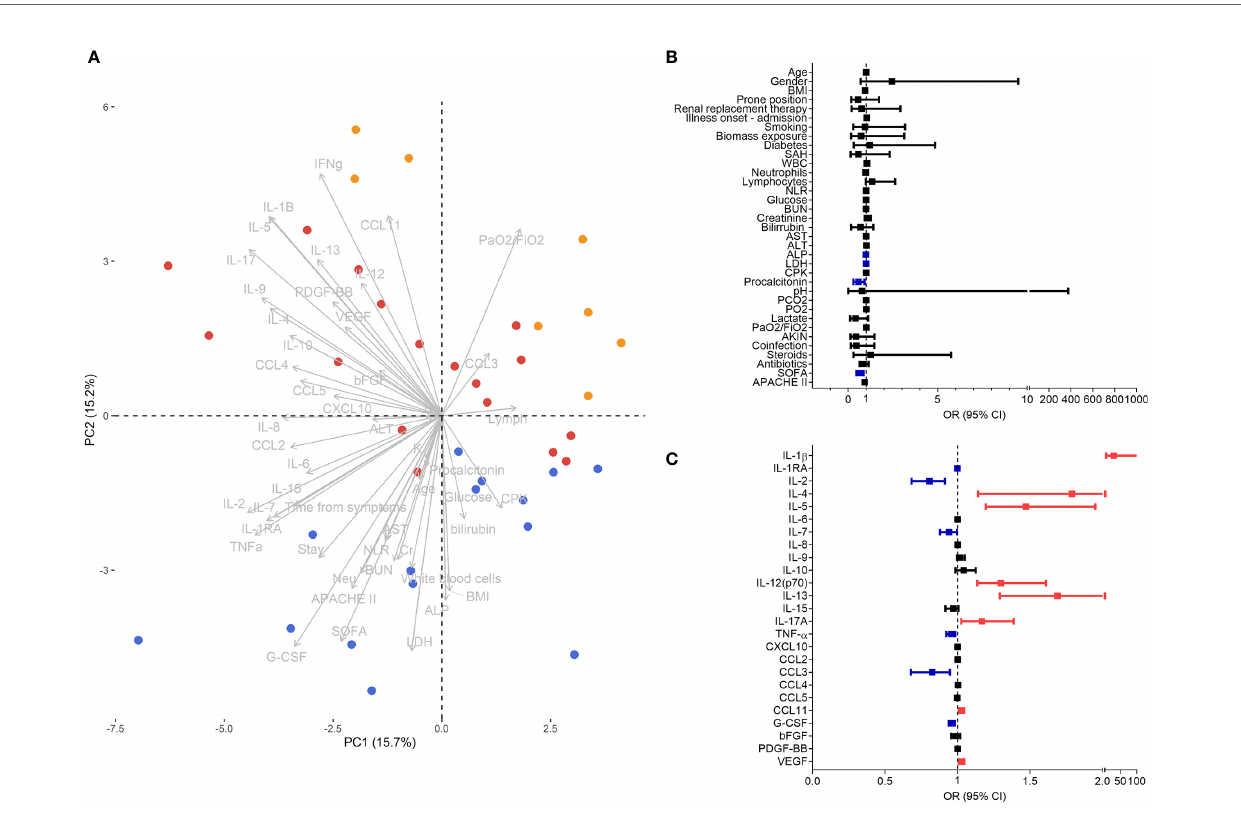
FIGURE 4 | Clinical and immunological factors that distinguish pandemic in fl uenza A(H1N1) and severe COVID-19. (A) Principal component analysis (PCA) of the clinical and immunological characteristics of study participants. Each dot represents a single individual, and each color represents a group of participants: blue for pandemic in fl uenza A(H1N1), orange for moderate COVID-19, and red for severe COVID-19. (B, C) Bivariate logistic regression analysis of the clinical and immunological characteristics associated with the causative pathogen in the two cohorts of patients with severe in fl uenza and COVID-19. The forest plots show the odds ratio (OR) and 95% CI interval values that were non-signi fi cant (black) and signi fi cant for severe COVID-19 (red). OR values of factors inversely associated with severe COVID-19 that instead predict pandemic in fl uenza A(H1N1) are shown in blue color. Absolute OR values are also presented in Supplementary Table 3